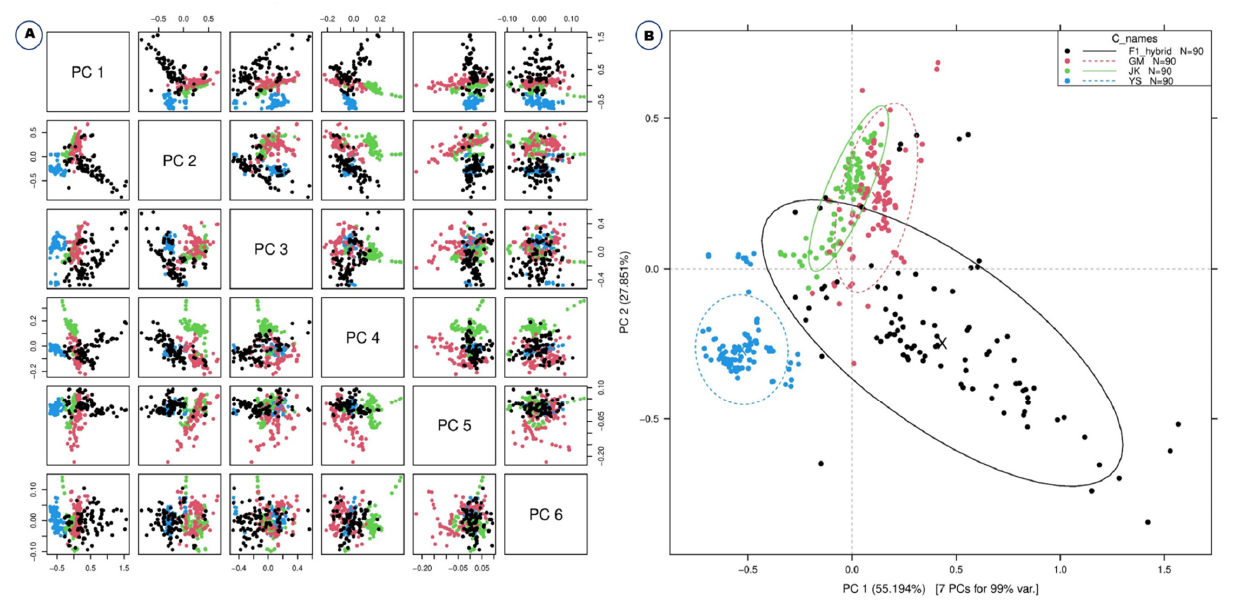
Figure 2. Principal Component Analysis (PCA) paired plot ( A ) and PC1 vs PC2 plot ( B ) for the visualization of B. napus , GM B. napus , B. rapa and F1 hybrids.